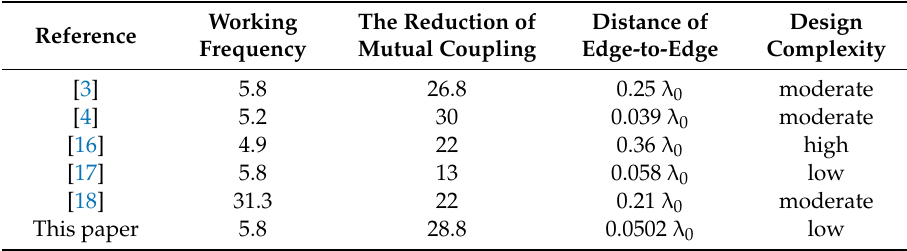
Table 2. Comparison between this design and others in the references of the MIMO